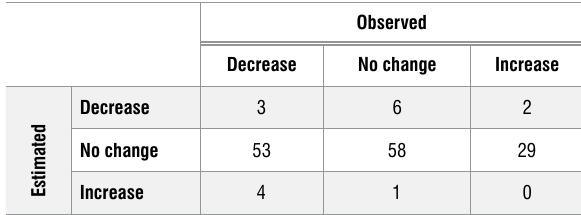
A cross-tabulation of categorical variables of the observed against estimated evaporation